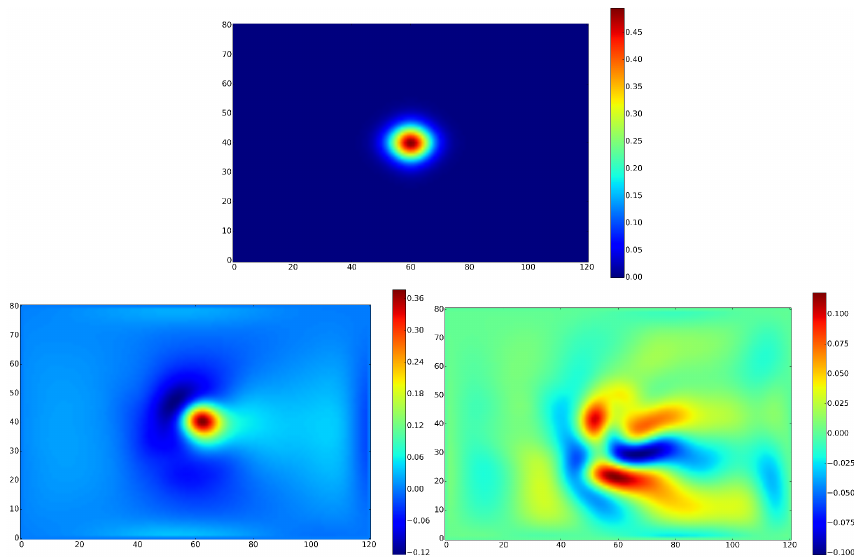
Figure 2. Assimilation increments in the SEABASS configuration corresponding to one sea surface height observation and a misfit of 0.5m. Coming from NEMOVAR 3D-Var (top) and 4D-Var (bottom) formulation. Two different assimilation window lengths are presented for the 4D-Var: 5 days (left) and 30 days